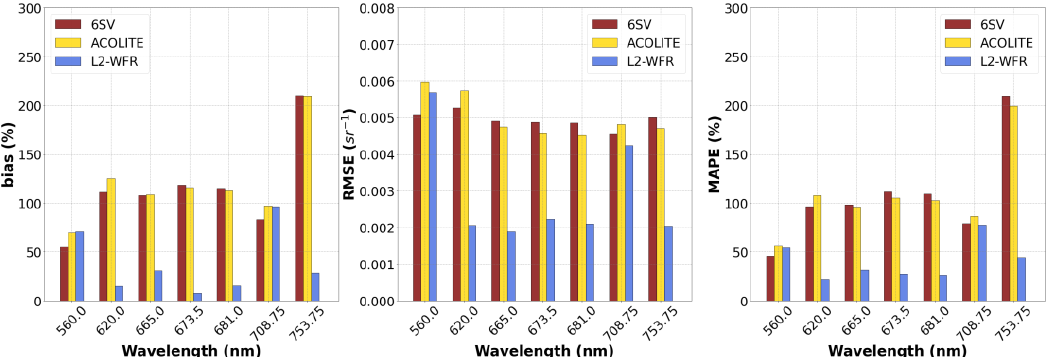
Figure 3. Plots of the median spectral statistic (bias, RMSE, and MAPE) for the three AC processors (L2-WFR, 6SV, and ACOLITE) for 3 October 2021 for the most critical wavelengths used in the PC models.